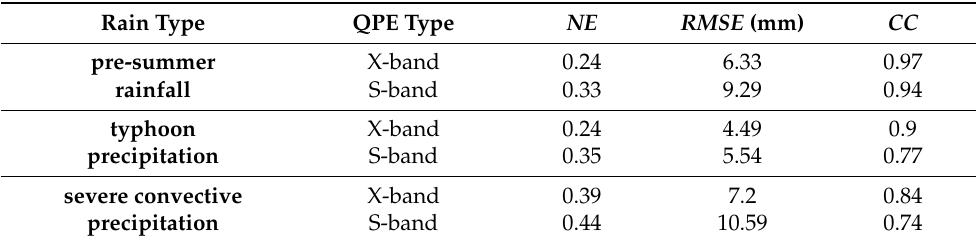
Table 3. The NE , RMSE , and CC for the estimation of hourly accumulated rainfall in pre-summer rainfall, typhoon precipitation, and severe convective precipitation for X- and S-band radars estimated by R ( K DP ) corresponding to Figure